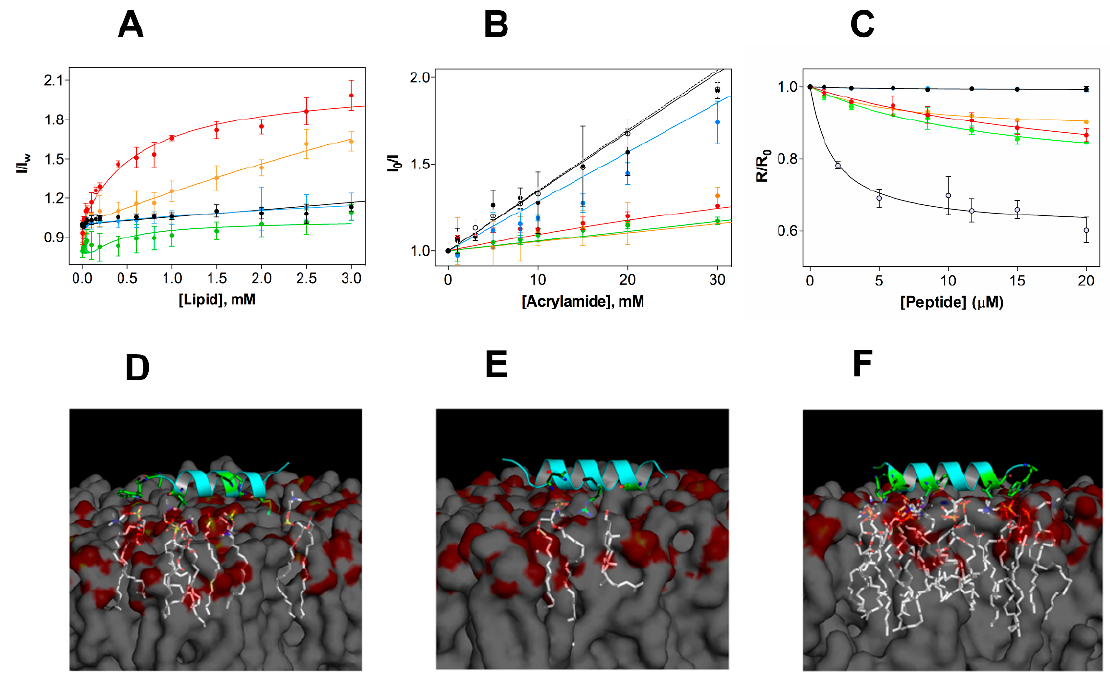
Figure 3. Experimental and in silico studies of the membrane selectivity of EcDBS1R4. ( A ) Partition curves of 6 µ M EcDBS1R4 to LUVs of di ff erent compositions. Solid lines represent fits obtained using Equations (2) and (3). The LUV compositions used were POPC (black), POPC:Chol 70:30 (blue), POPC:POPG 70:30 (red), IML (POPE:POPG:CL 63:33:4) (green) and OML (POPE:POPG:CL:LPS 80:16:1:3) (orange). ( B ) Fluorescence quenching by acrylamide of 6 µ M EcDBS1R4 in the absence (open circles) and presence of LUVs (color code as in A). Solid lines represent fits obtained using Equations (4) and (5). ( C ) Changes in membrane dipole potential as a function of EcDBS1R4 concentration, measured with di-8-ANEPPS (4-(2- [6-(dioctylamino)-2-naphthalenyl]ethenyl)-1-(3-sulfopropyl)pyridinium inner salt) in LUVs (200 µ M lipid concentration; color code as in A) and E. coli cells (1 × 10 4 cells / mL), represented by grey filled circles. The plot represents the di-8-ANEPPS excitation ratio R ( I 455nm / I 525nm ) for each peptide concentration, normalized divideing by R 0 (the R value in the absence of peptide). Solid lines represent fits obtained using Equation (6). The parameters obtained from the fittings are summarized in Table 2. All experiments were conducted in triplicate. ( D – F ) Three-dimensional theoretical representation of the peptide interacting with membranes composed of POPC ( D ), POPC:Chol (70:30) ( E ) and POPC:POPG (70:30) ( F ), indicating the amino acid residues (in green) and the phospholipid molecules (in white) possibly involved in the interactions (residues involved and distances of interactions occurring for each membrane are detailed in Supporting Information Table